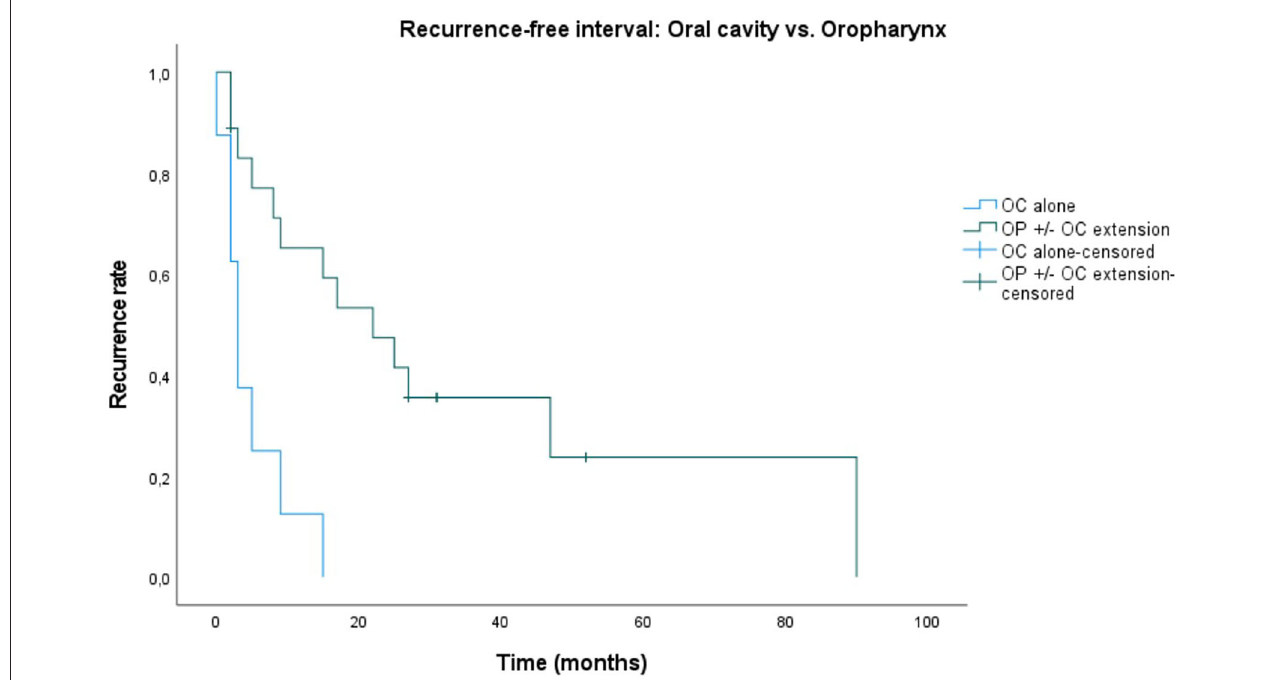
FIGURE 4 | Kaplan–Meier plot showing statistically significant difference in recurrence-free interval ( p < 0.001) for oropharyngeal squamous cell carcinoma (with or without oral cavity extension) treated with photodynamic therapy, compared to oral cavity tumors alone. Starting point in time is PDT illumination date until local recurrence. OC, oral cavity; OP ± OC extension, oropharyngeal squamous cell carcinoma with or without oral cavity